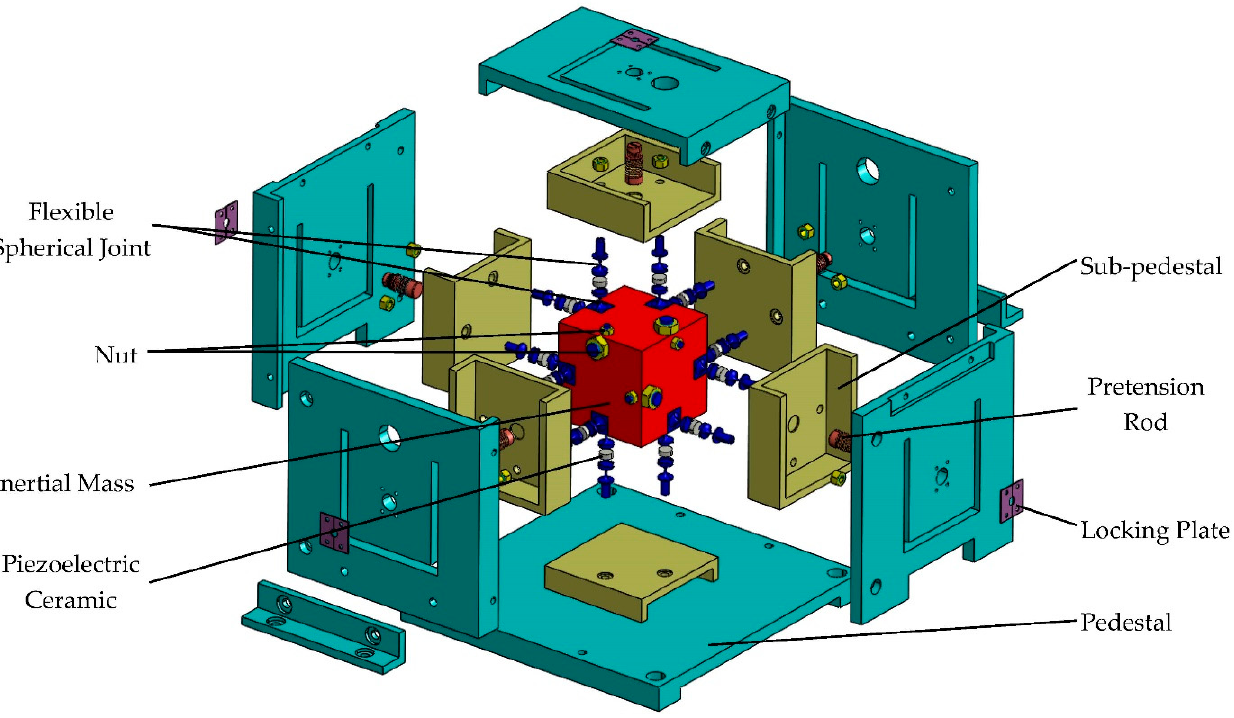
Figure 2. The exploded 3-D drawing of the six-axis accelerometer.